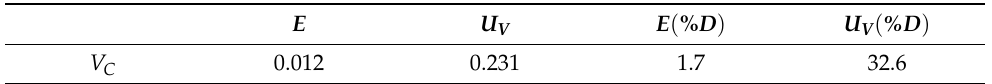
Table 6. Validation of V C